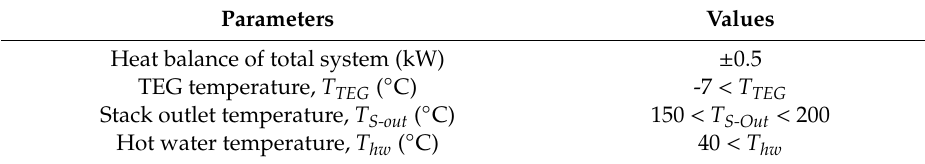
Table 4. Appropriate operating conditions of high-temperature PEMFC stack system.